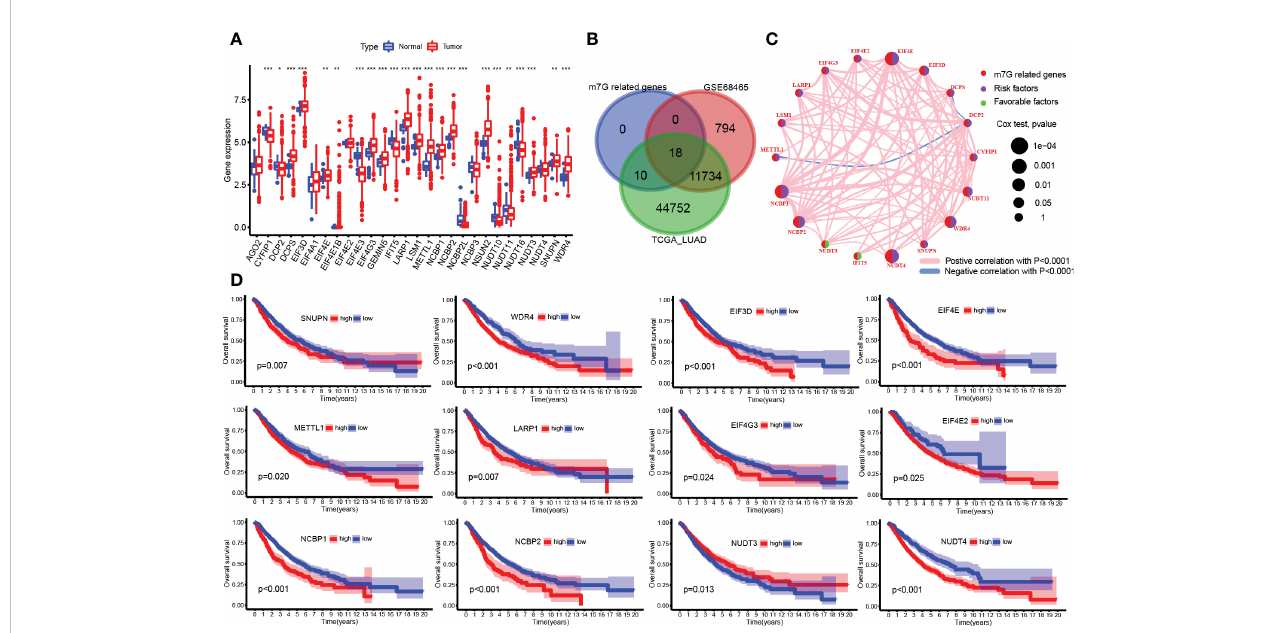
FIGURE 2 N7-methylguanosine (m7G)-related gene expression and survival analysis. (A) Boxplot of m7G-related gene mRNA expression between tumor and normal samples. (B) Venn plots for common existing genes in the three groups. (C) Correlation network between m7G-related genes. (D) Survival plot of m7G-related genes. (*P <0.05, **P < 0.01, ***P < 0.001, ns: Not statistically signi fi